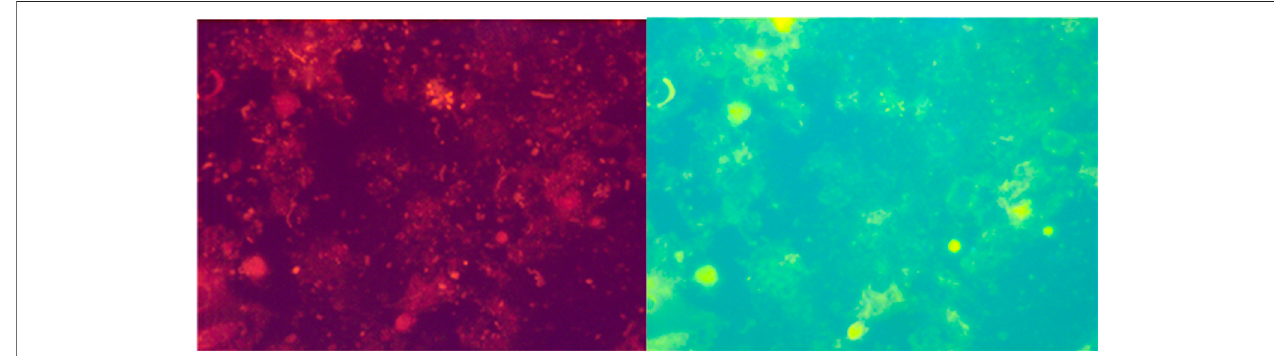
FIGURE 5 | Fluorescence image (ammonium oxidizers and nitrite oxidizers).